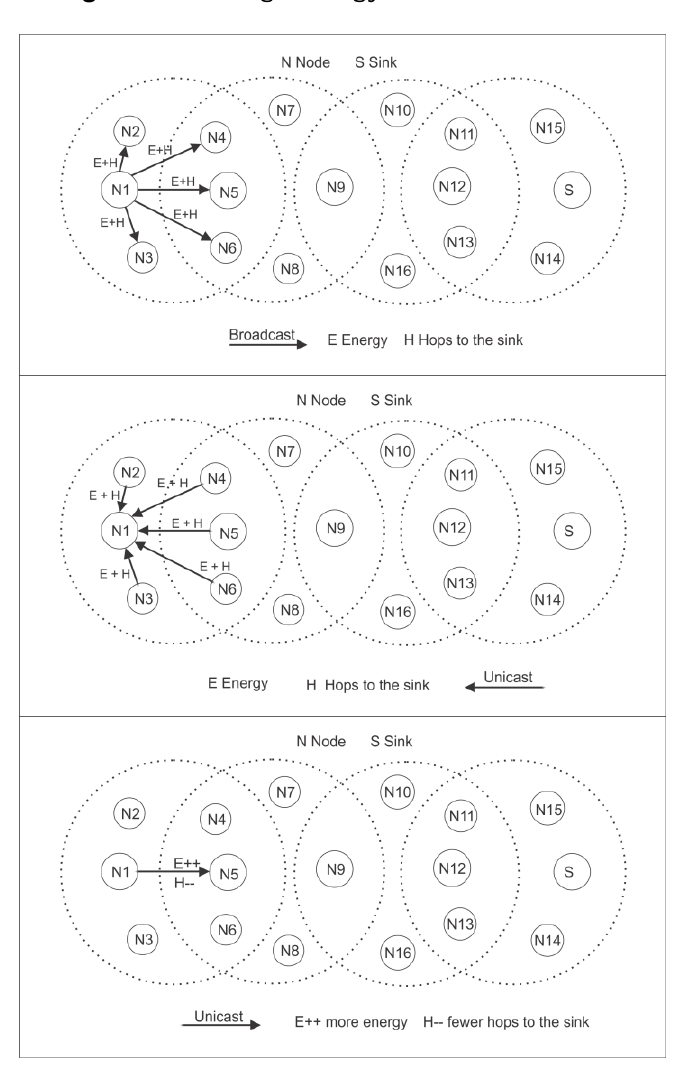
Figure 4. Routing Strategy for flat